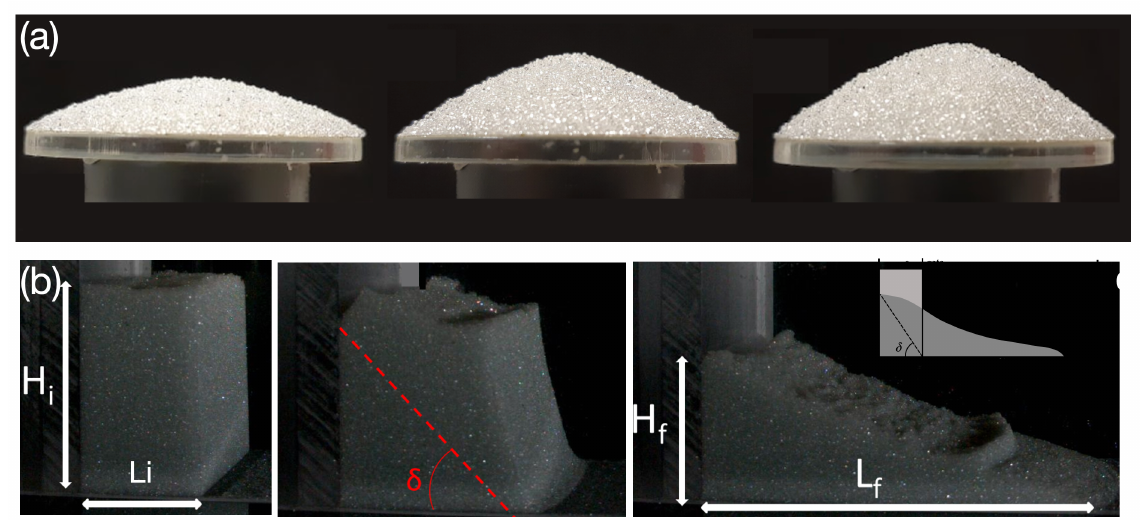
Figure 6. (a) Images of piles for a CCGM with d = 480 µ m with increasing PBS coating; from left to right: no coating, slope = 27 . 7 o ± 0 . 8, b = 52nm slope = 40 . 3 o ± 1 . 9, b = 62 nm, slope = 42 . 5 o ± 2 . 2; (b) Dam break experiments of a cohesive material with d = 0 . 8 mm and b = 200nm. The three pictures illustrate the initial state, the onset of the flow and the final